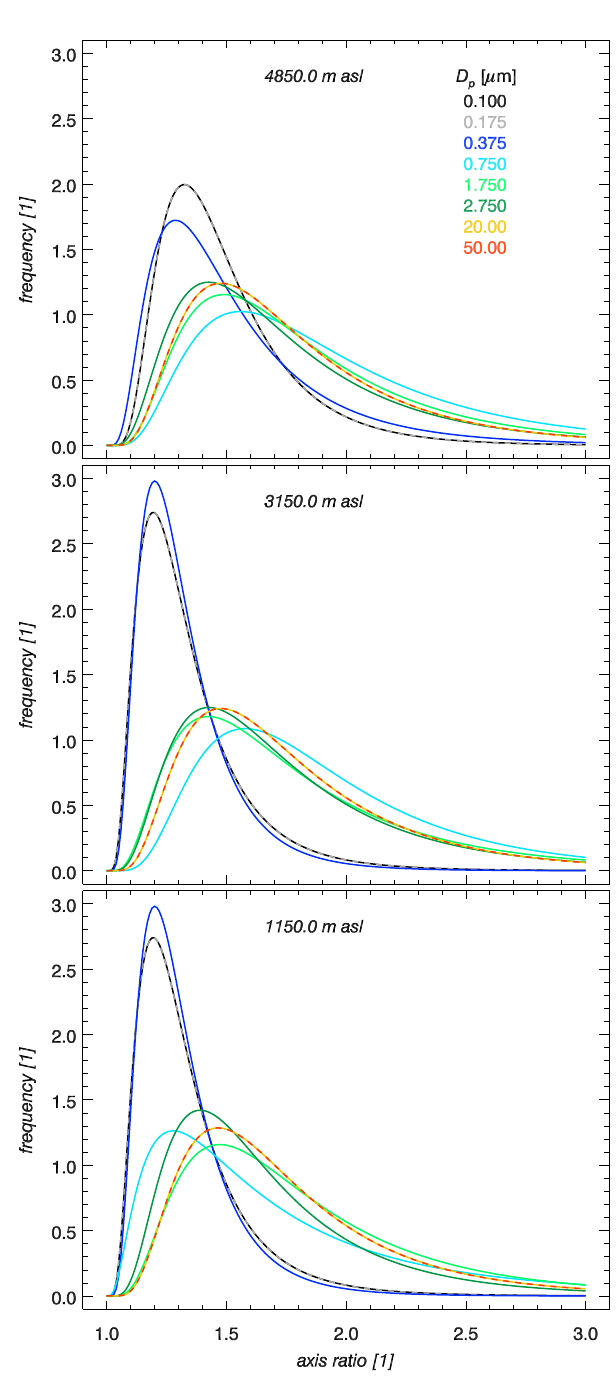
Fig. 1. Frequency of dust particle axis ratio (AR) as a function of particle size D p and altitude, derived by Kandler et al. (2009) on 19 May 2006 during SAMUM-1 over Morocco. The cross sections of the individual particles were measured and fitted to ellipses of certain ARs. Although the observations did not provide information about the real particle shape, a prolate spheroid was assumed w.r.t. each particle by rotating the ellipse around the longest half axis to derive D p as the volume-equivalent diameter of this